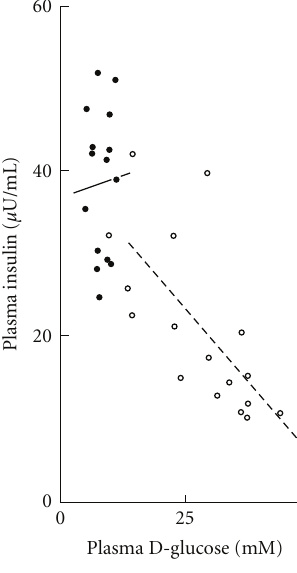
Figure 4: Comparison between plasma insulin and D-glucose concentrations found at sacrifice in control (closed circles and solid line) and STZ (open circles and dashed line) rats. The two oblique lines correspond to the regression